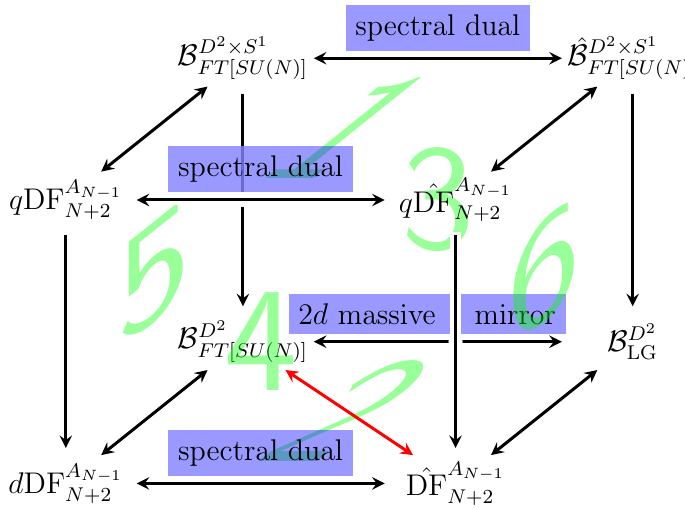
Figure 3 . Duality web III. Figure 1 is the top face (face 1 ) of the cube. The arrows going downstairs correspond to q ! 1 limits. Notice that the two theories related by the spectral duality tend to di(cid:11)erent theories under q ! 1. This asymmetry appears because one needs to choose the scaling of the parameters with q and the spectral duality map relates two di(cid:11)erent choices. the internal momenta, or Coulomb branch parameters). In this way the q -Toda A correlator with N semi-degenerate and two full primary operators reduces to the q